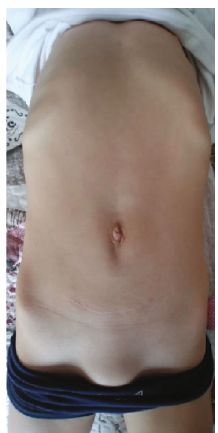
Figure 3: Esthetic results at